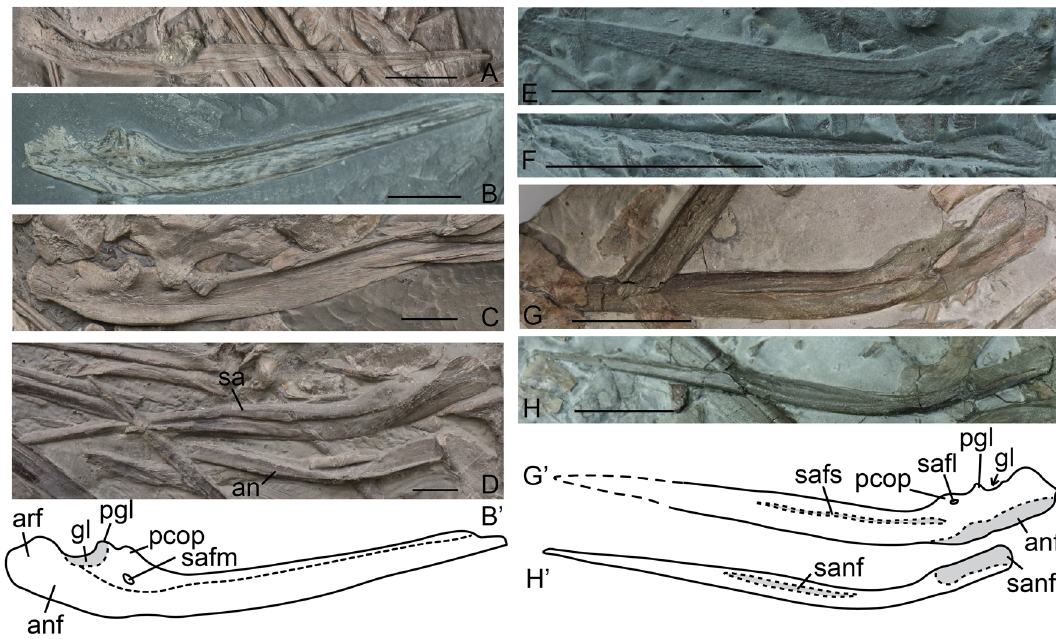
Figure 7. Surangulars in medial ( A – C ) and lateral ( D , E , G ) and angulars in medial ( D , F , H ) view of selected specimens of Stenopterygius . Interpretative drawings denoted by an apostrophe with their corresponding letter. ( A ) stage 4 embryo S. quadriscissus SMNS 81961; ( B ) postnatal 2 S. quadriscissus SMNS 51551; ( C ) sexually mature S. quadriscissus SMNS 81961; ( D ) sexually mature S. quadriscissus SMNS 80234; ( E ) stage 3 embryo S. quadriscissus SMNS 80234; ( F ) stage 3 embryo S. quadriscissus SMNS 80234; ( G ) postnatal 1 S. quadriscissus SMNS 51139; ( H ) postnatal 1 S. quadriscissus SMNS 51139. anf angular facet, arf articular facet, gl glenoid, pcop paracoronoid process, pgl preglenoid process (insertion MAME), safl lateral surangular foramen, safm medial surangular foramen, safs surangular fossa, sanf surangular facet. Scale bar: ( A – H ) = 30